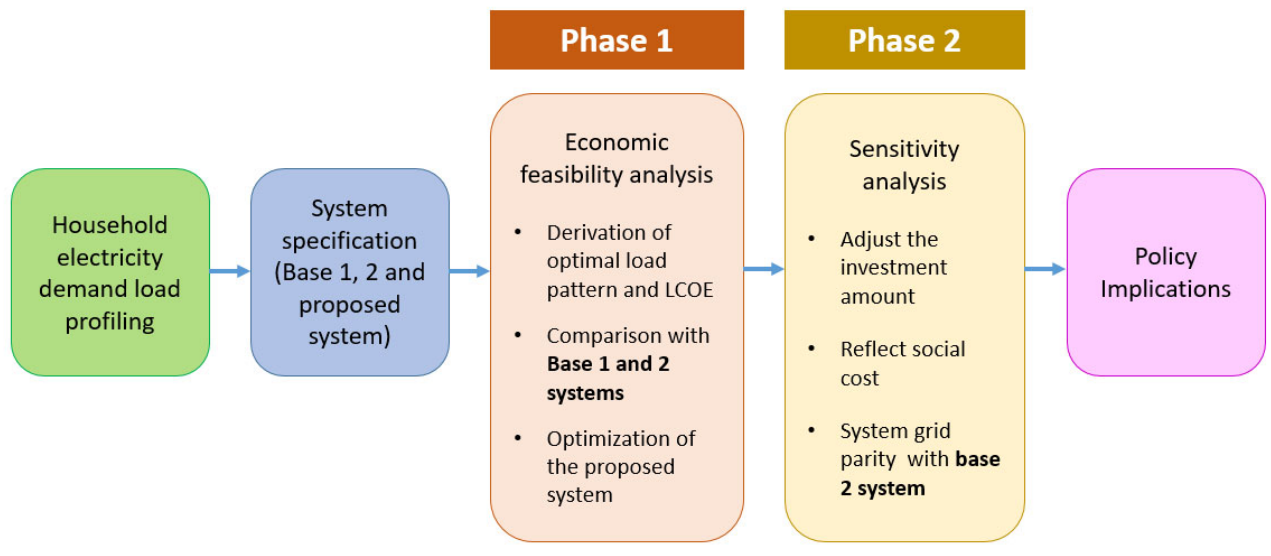
Figure 2. Research Figure 2. Research framework.